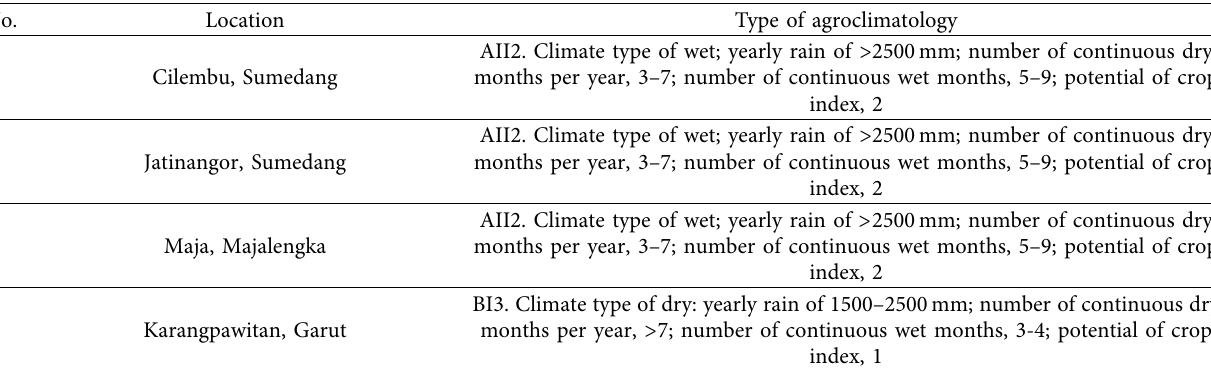
Table 2: Agroclimatology of the location in West Java, Indonesia.